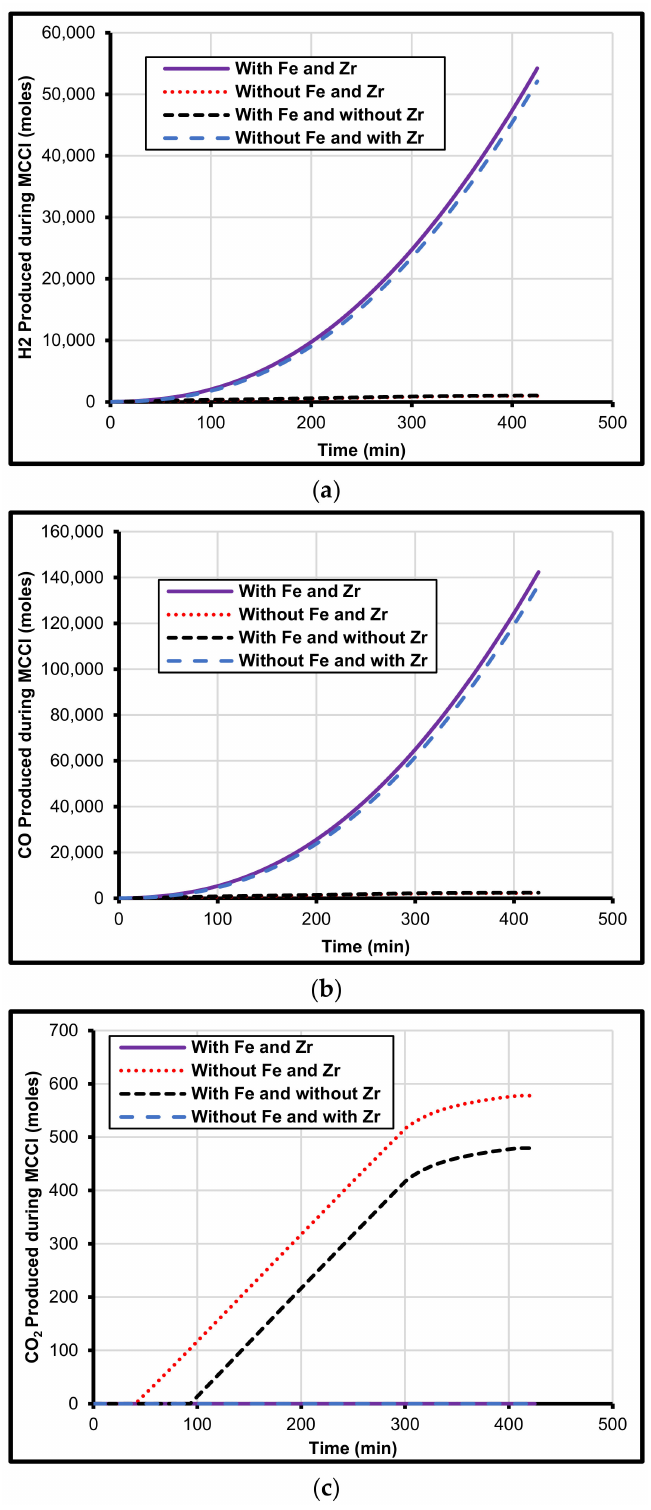
Figure 14. Effect of Fe, Zr, and their various combinations during MCCI at 425 min on the production of ( a ) hydrogen gas, ( b ) carbon monoxide gas, and ( c ) carbon dioxide